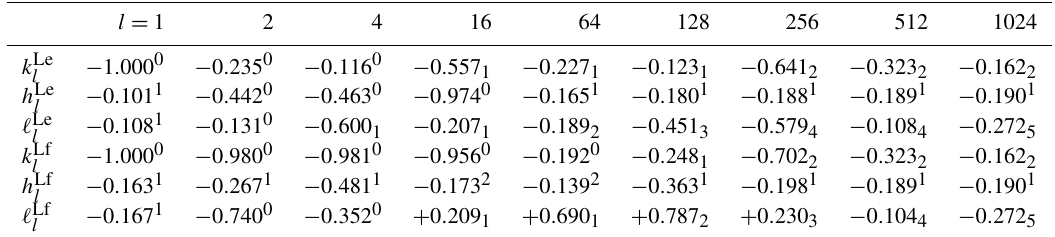
,h Te ,l Te ) 2 2 2